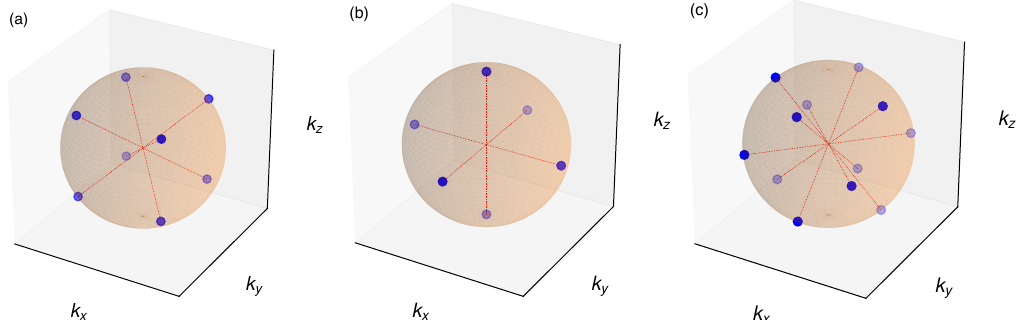
Figure 4: Gapless nodes in the Bogoliubov quasiparticle dispersions for odd-parity order parameters formed by fermions belonging to j = 1 / 2 or j = 3 / 2 sectors inde- pendently. The point nodes are indicated by the blue dots, while the orange sphere is the itinerant electron Fermi surface. The red-dashed lines are for ease of view- ing the gapless point nodes along the various cubic axes. (a): Gapless nodes for = 1,3 T J , T J = 3 order parameters resulting from two-channel Kondo interaction are lo- + ( 1,2,3 ) 2 = 1,3 order cated along body diagonal [ 111 ] directions. (b): Gapless nodes for T J − ( 1,2,3 ) parameters resulting from two-channel Kondo interaction are located along primary = 1,3 = 1,3 cubic ˆ e axes. (c): Gapless nodes for T J , T J , T J = 3 resulting from novel i + ; j = 3 / 2 − ; j = 3 / 2 2; j = 3 / 2 Kondo interaction are located along the [ 1 ± 10 ] , [ 10 ± 1 ] , [ 01 ± 1 ]